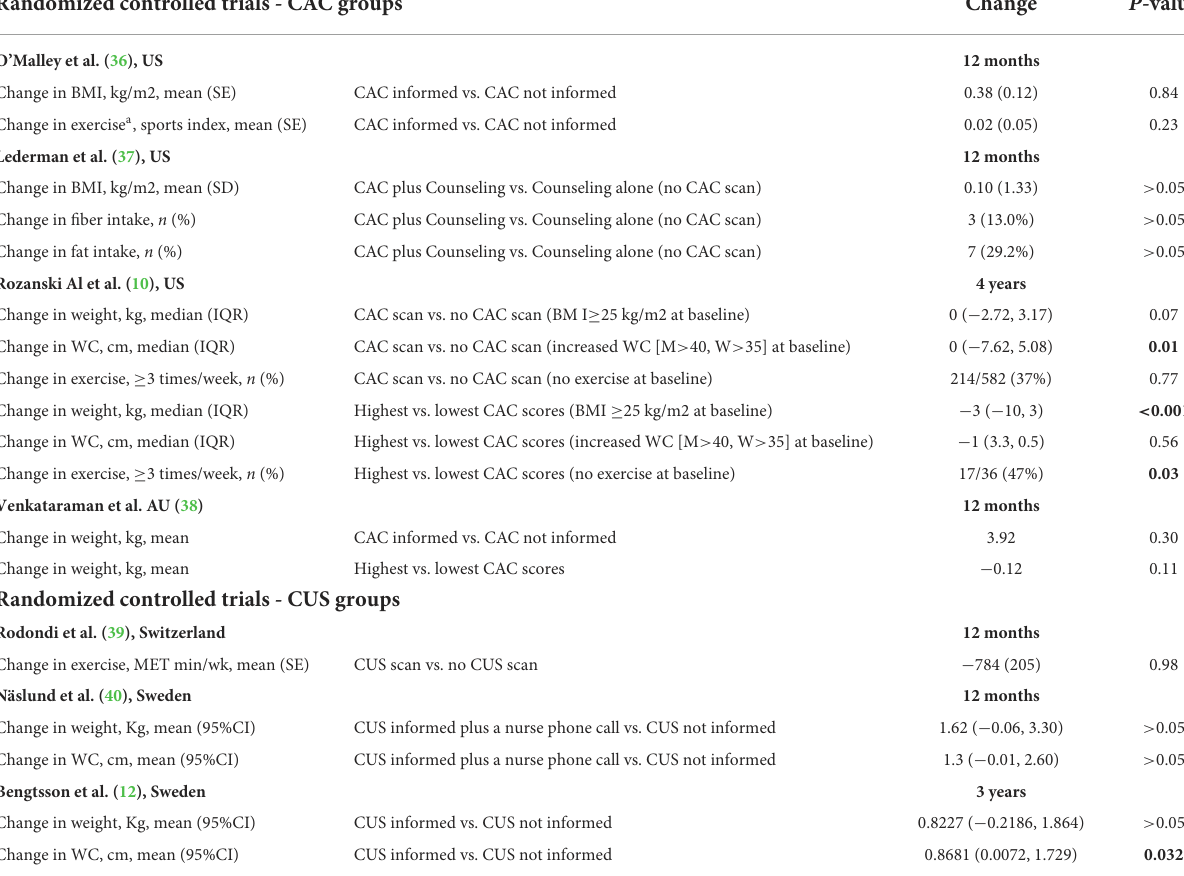
TABLE 5 Changes in diet, physical activity and anthropometric measures according to CAC and CUS scores in RCTs. Randomized controlled trials - CAC